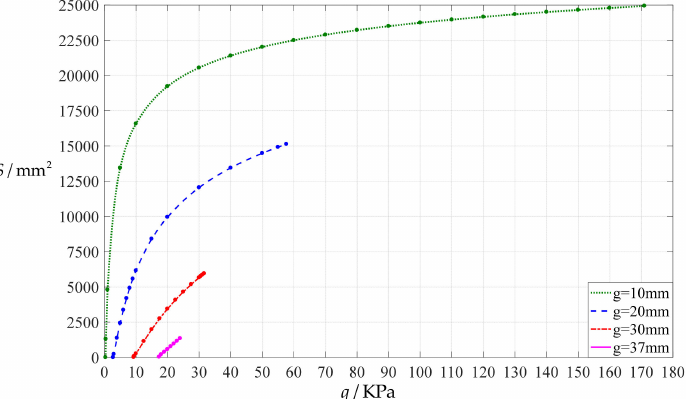
Figure 4. The variations of the contact areas S = π d 2 with the pressure q for a = 100 mm, h = 1 mm, t = 0.1 mm, E = 7.84 MPa, ν = 0.47, and g = 10 mm, 20 mm, 30 mm, and 37